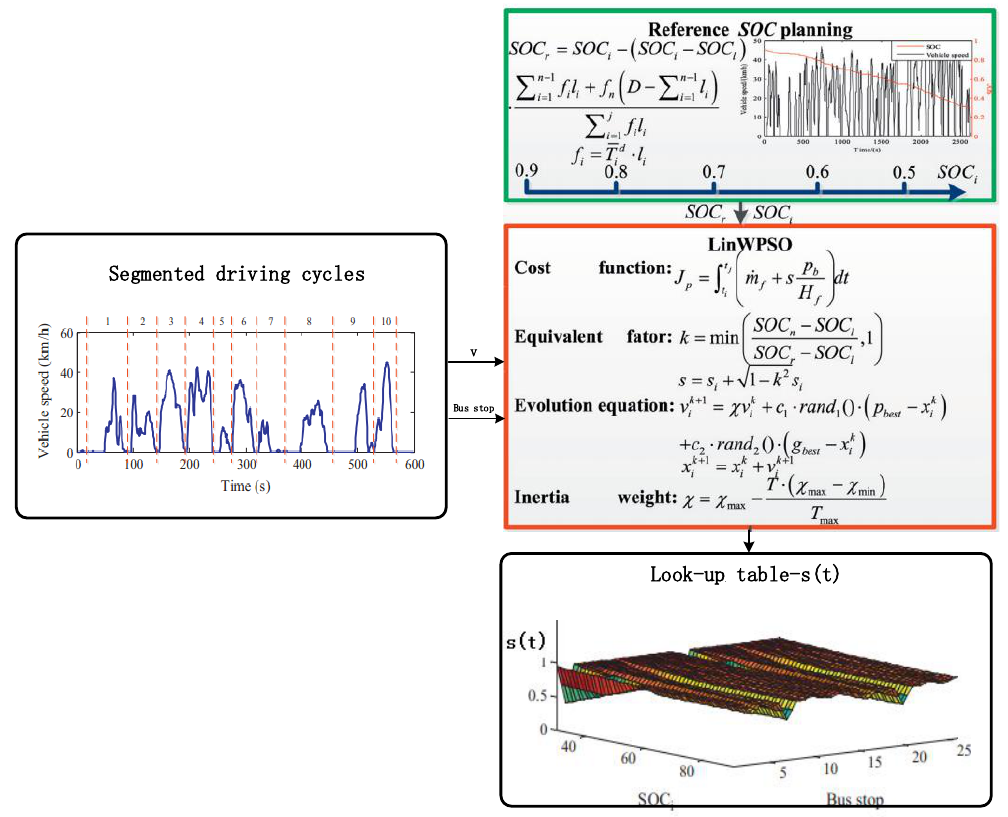
Figure 7. Flowchart of solution process of s ( t ).